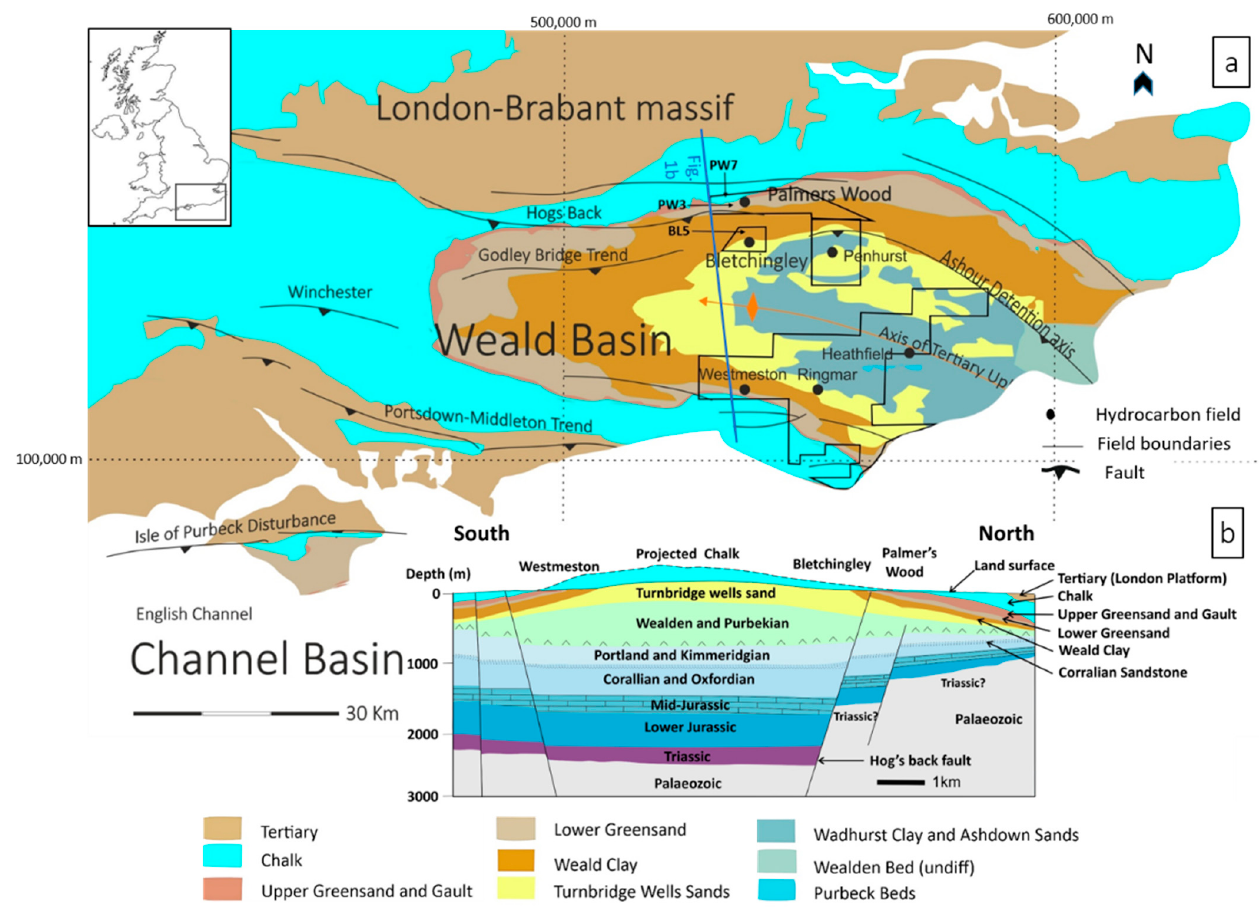
Figure 1. ( a ) Location map of the Weald Basin showing surface geology with major structural trends ( b ) Schematic of the subsurface through the line of section in ( a ) as adapted from Andrews [7]; Butler and Pullan [19].